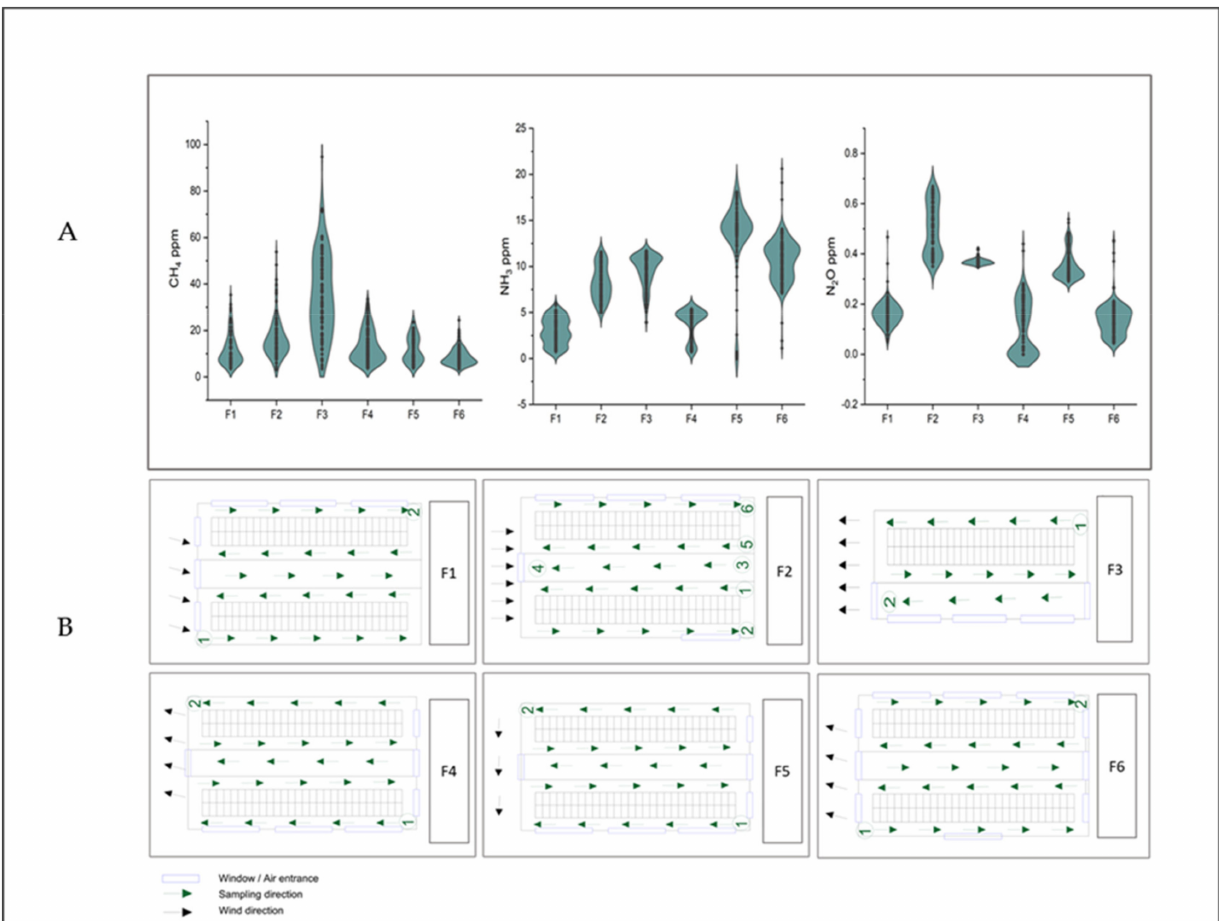
Figure 4. ( A ) Emission concentrations of CH 4 , N 2 O, and NH 3 in all the barns; ( B ) diagram of the measurement sampling and architectural volume in the